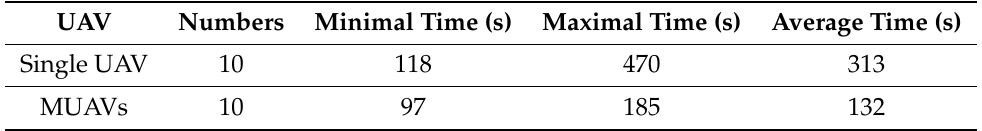
Table 3. Mapping time comparison of a single UAV vs.